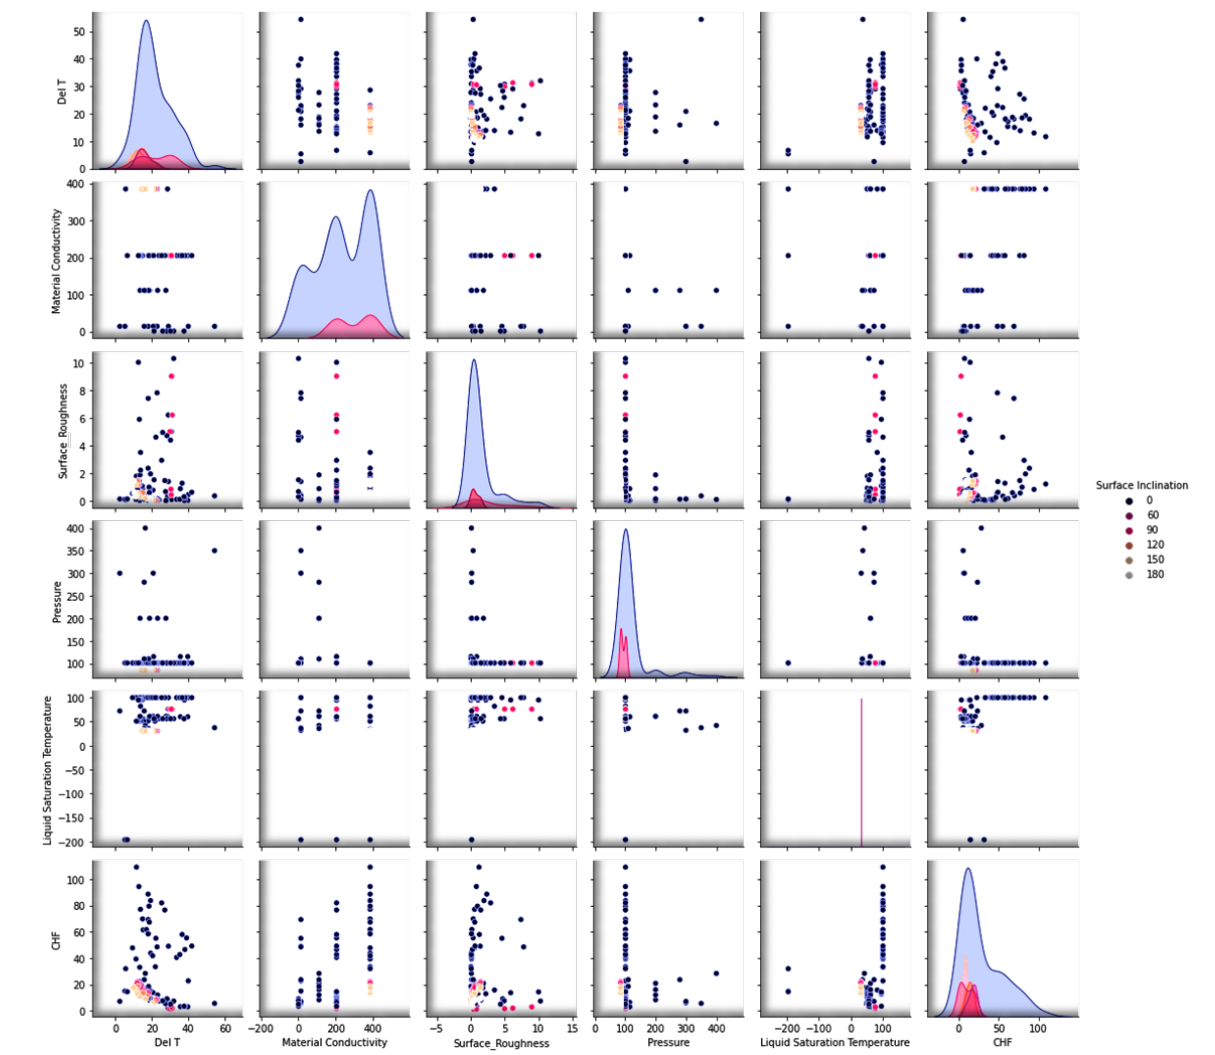
Figure 3. Visualizing the experimental CHF data in terms of the surface inclination, liquid saturation temperature, pressure, surface roughness, and material conductivity.